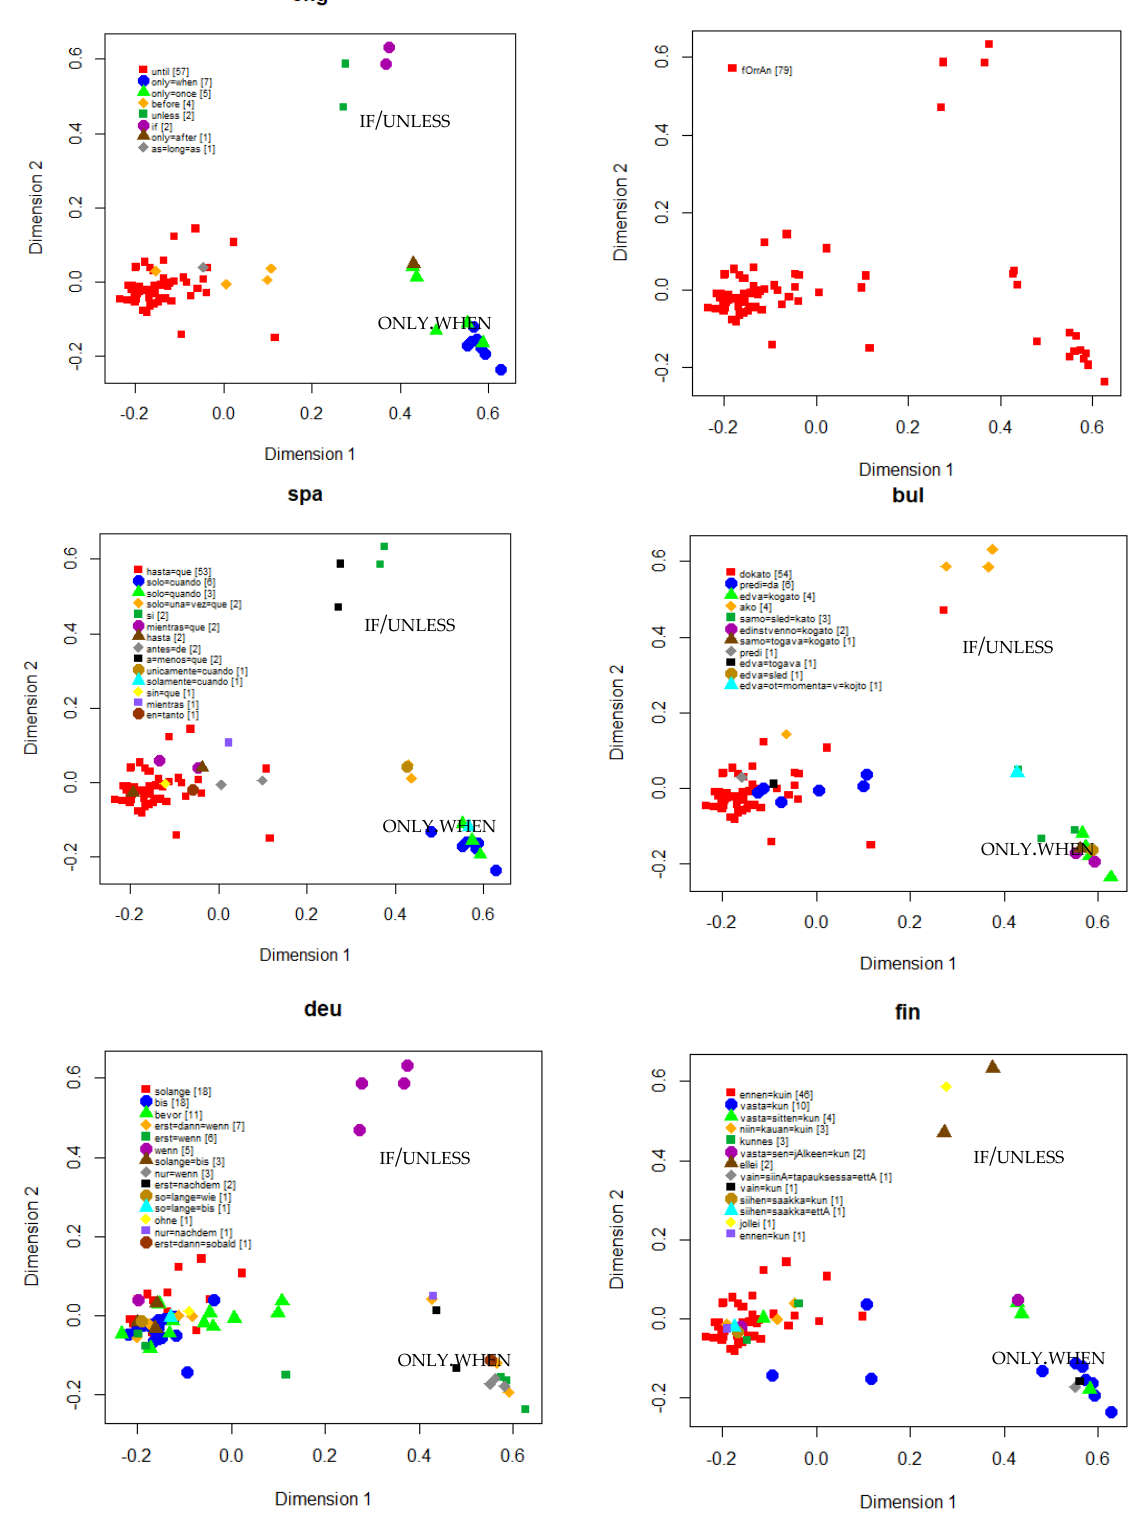
Figure 3. MDS plots with symbols indicating language-specific lexicalizations.